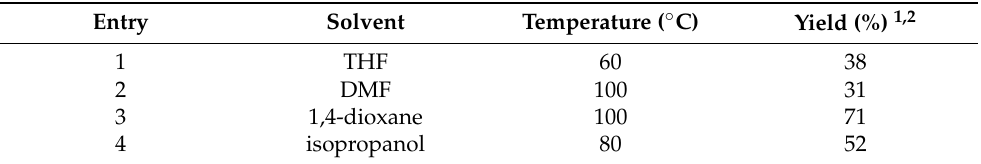
Table 1. The isolated yield of product 3 after Suzuki coupling of 2,4-dichloropyrimidine ( 1 ) with phenylboronic acid ( 2 ) in four selected solvents.